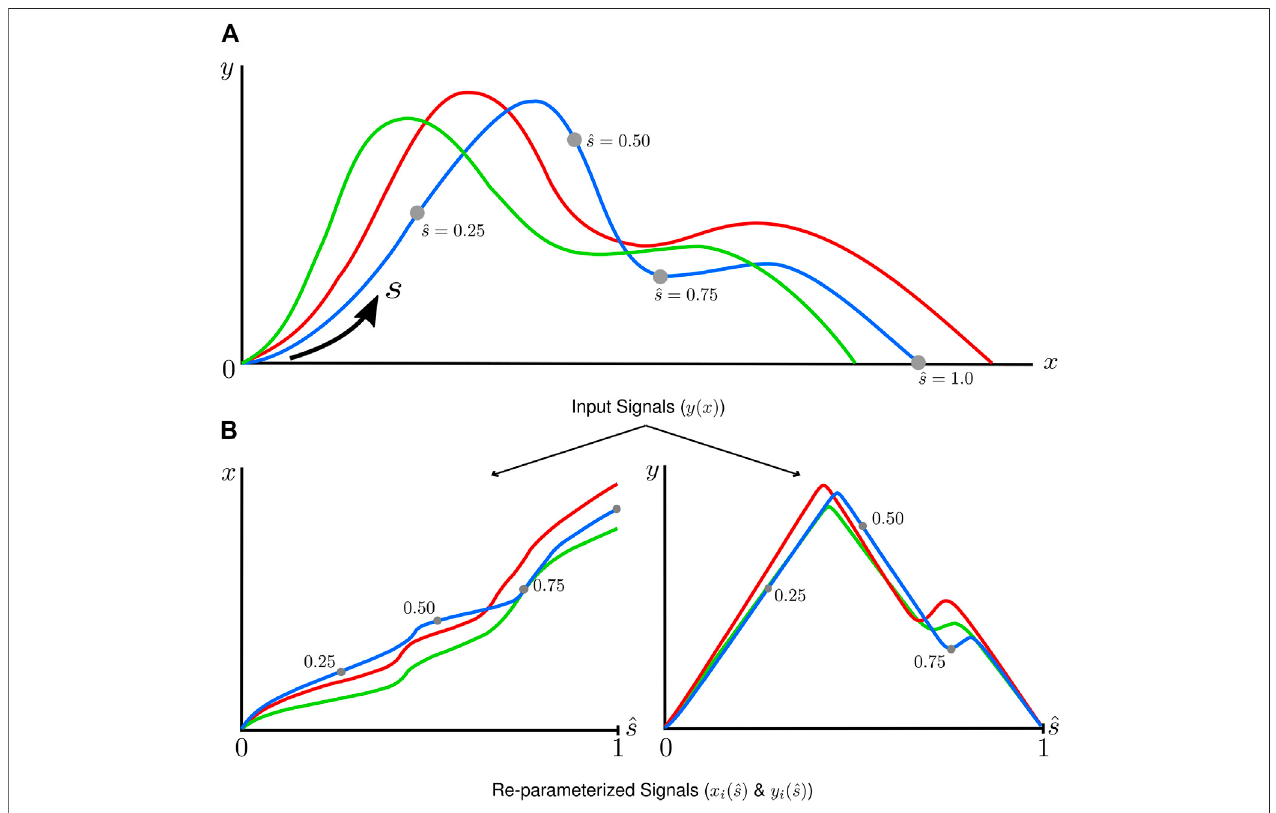
FIGURE 2 | A graphical depiction of the arc-length re-parameterization process, where input signals (A) de fi ned y ( x ) are re-parameterized into two curves ( x i ( ^ s ) and y i ( ^ s ) ) with respect to arc length (B)